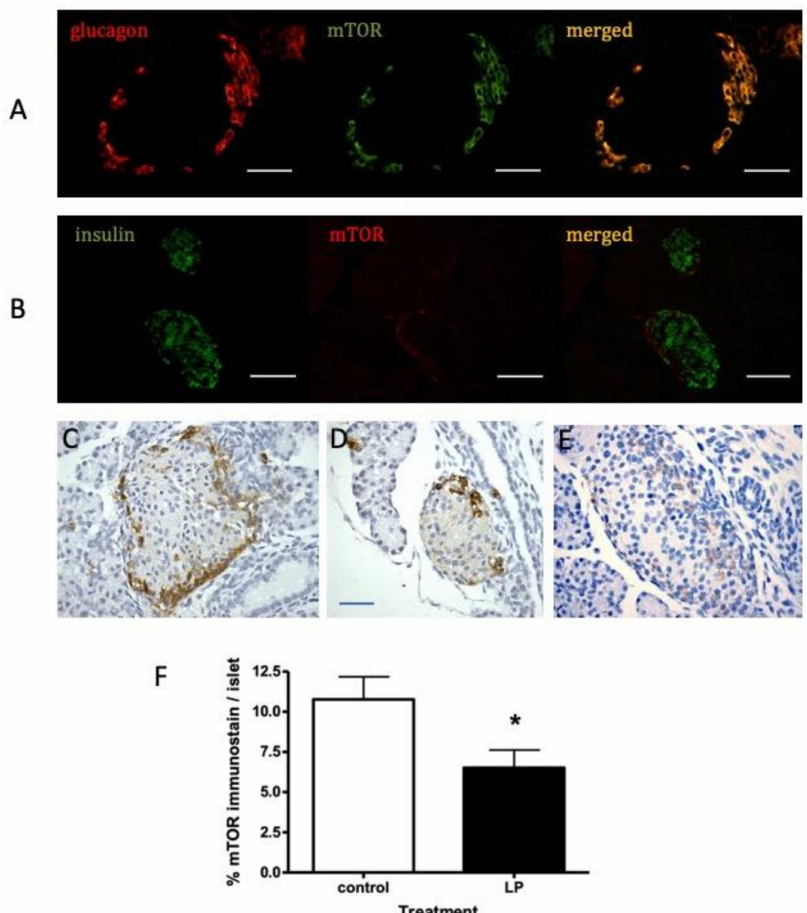
Figure 2. Representative images of immunofluorescent staining showing co-localization of ( A ) glucagon (red) and mTOR (green) and ( B ) insulin (green) and mTOR (red) in pancreatic islets from control-diet fed mouse at age 30 days (6 mice examined). Immunohistochemical localization of mTOR in similar islets is shown using diaminonezidine (DAB) chromogen in islets from 7 day old control diet-fed mice ( C,D ) or LP diet ( E ). The percentage area of islets occupied by mTOR-positive cells is shown for control or LP diet-fed mice in panel F (mean ± SEM; n = 6, * p < 0.05 vs. control diet). Scale bars represents 50 µ